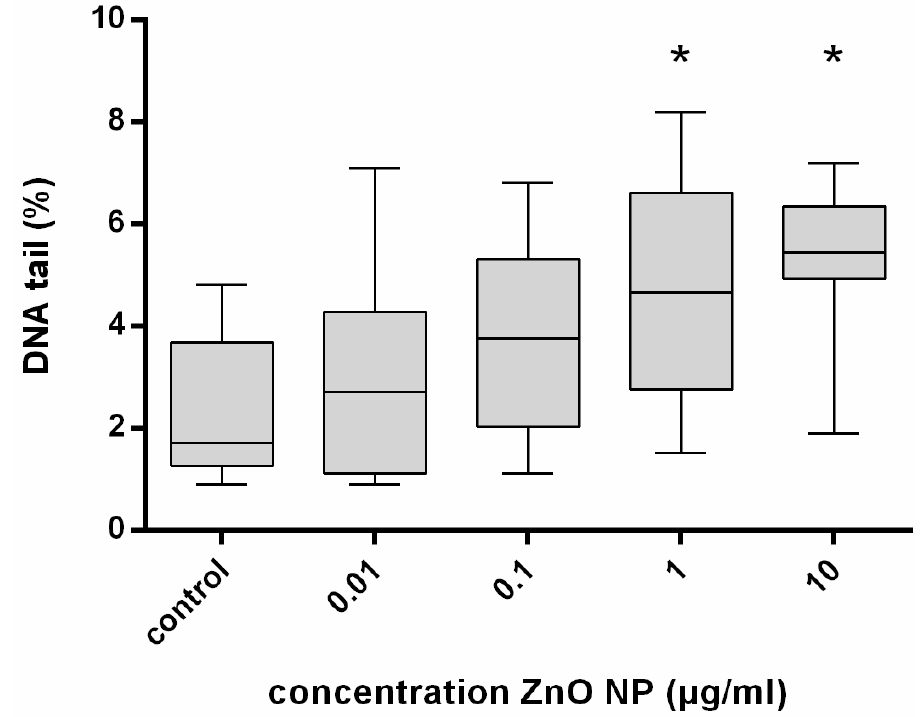
Figure 5. DNA damage expressed by the percentage of DNA in the tail of hMSC after exposure to ZnO-NP. Bronchial Epithelial Cell Growth Medium served as control, and 300 mM MMS as positive control. Cells were treated for 24 h; n = 8. For statistical analysis, the Wilcoxon Test was performed. Significant increase in DNA damage was observed at ZnO-NP concentrations of 1 and 10 µ g/mL. *: Statistical significance compared with the control based on a p -value <